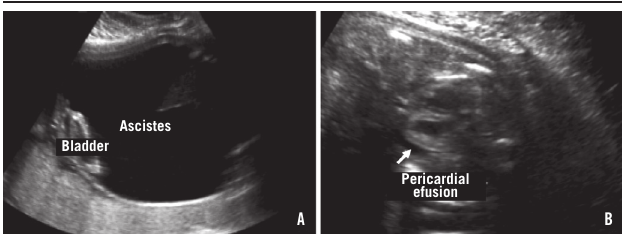
figurE 2 − 25-weeks ultrasound scan images showing severe ascites (A) and pericardial effusion (B) (see white